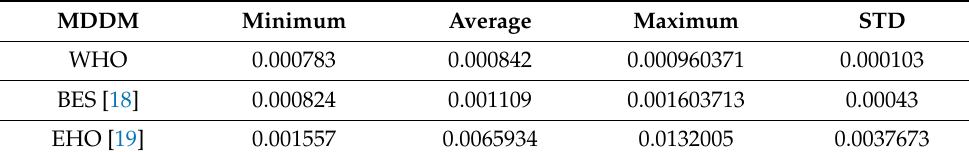
Table 4. The statistical results of MDDM for WHO and other algorithms.